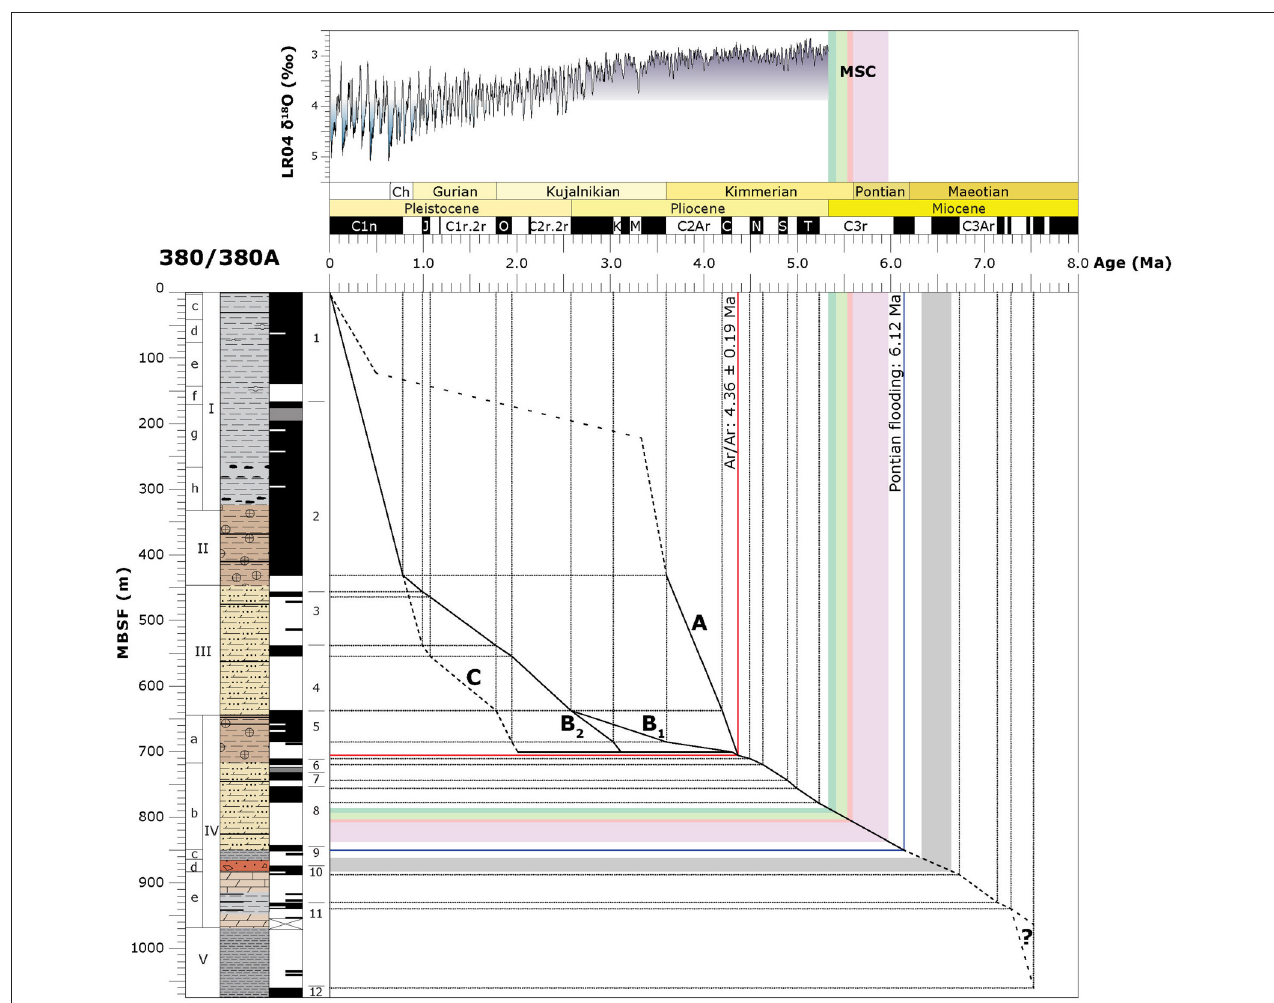
FIGURE 7 | Age depth correlation for Hole 380/380A, indicating three options (A–C) for the upper 700 m. The red line at 706 mbsf indicates the position of the 40 Ar/ 39 Ar dated ash-layer of Van Baak et al. (2015b) and the blue line the dinoflaggelates cyst datum of Grothe et al. (2014), in gray the anomalously coarse Unit IVd. From top to bottom: stacked δ 18 O record of benthic foraminifera (Lisiecki and Raymo, 2005); Black Sea regional stages (Ch = Chaudian) after Zubakov (1988) and Nevesskaya et al. (2003); Hole 380/380A lithological units; Geomagnetic Polarity (Hilgen et al., 2012), colors for the Messinian salinity crisis (MSC) interval represent the individual stages of the MSC [after Roveri et al. (2014)]; Age (Ma).